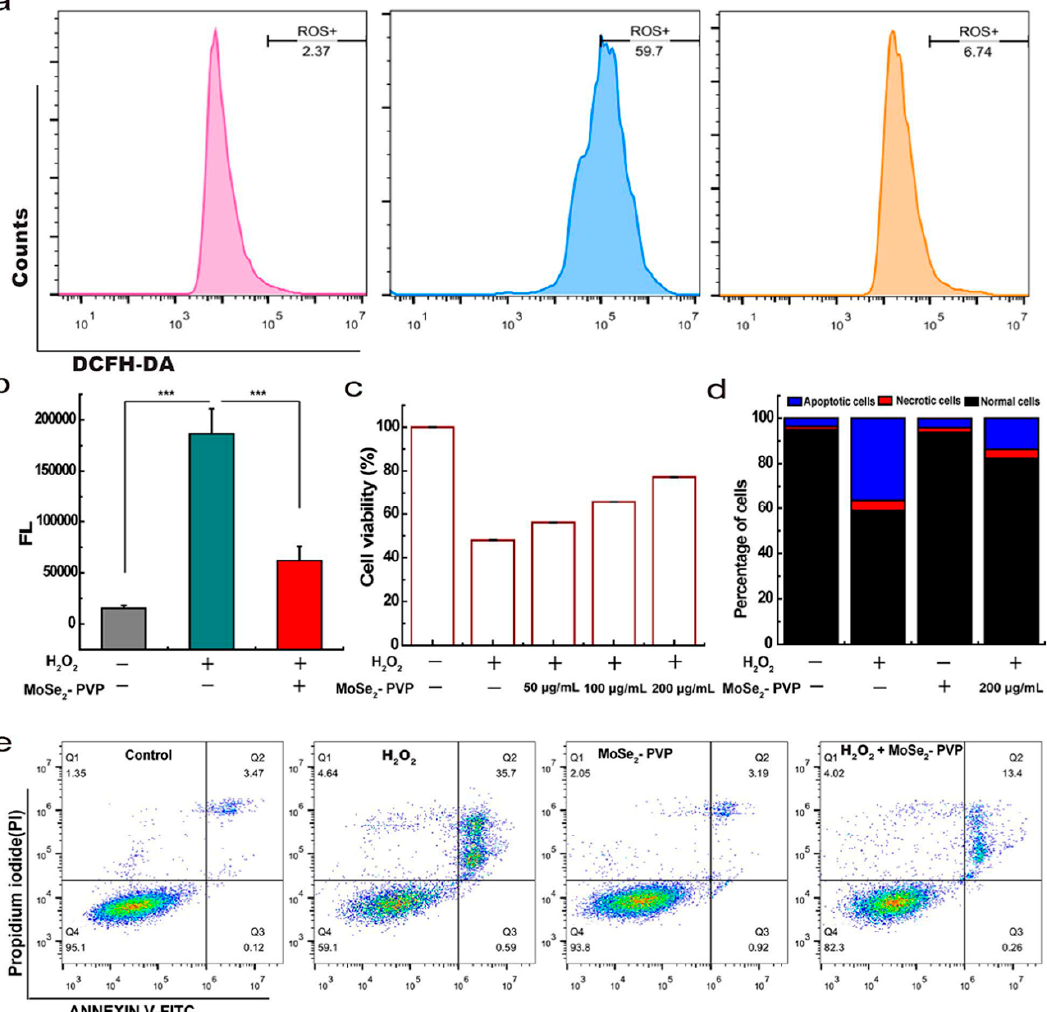
Figure 5. ( a ) Quantitative analysis of ROS levels in RAW264.7 cells (left: healthy cells; middle: H 2 O 2 - treated RAW264.7 cells; right: H 2 O 2 /MoSe 2 -PVP NPs-treated 264.7 cells). ( b ) Quantitative analysis of ROS levels in RAW264.7 cells (H 2 O 2 − : without the H 2 O 2 ; H 2 O 2 +: with the H 2 O 2 ; MoS 2 -PVP − : without the MoS 2 -PVP). ( c ) Histogram of RAW264.7 cells vitality after treatment with 500 μ M H 2 O 2 and different concentrations of MoSe 2 -PVP NPs. ( d ) Histogram of apoptosis and necrosis in untreated and MoSe 2 -PVP NPs-treated RAW264.7 cells ( e ) of cell apoptosis and necrosis distribution in untreated and MoSe 2 -PVP NPs-treated RAW264.7 cells. *** p < 0.001, Representative graphics are shown, Reprinted from [115]. Copyright